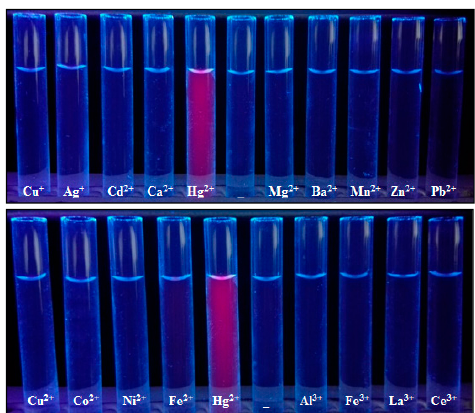
Figure 5. Naked-eye observation of the fluorescence recovery for AlS 4 P C -Alcian blue 8GX in the presence of different metal ions including Hg(II) in an aqueous medium. The concentration of AlS 4 Pc was 1.0 × 10 − 6 mol/L, Alcian blue 8GX was 1.50 × 10 − 6 mol/L and EDTANa 2 was 1.0 × 10 − 4 mol/L. The concentration of all of the metal ions added was 1.0 × 10 − 4 mol/L.